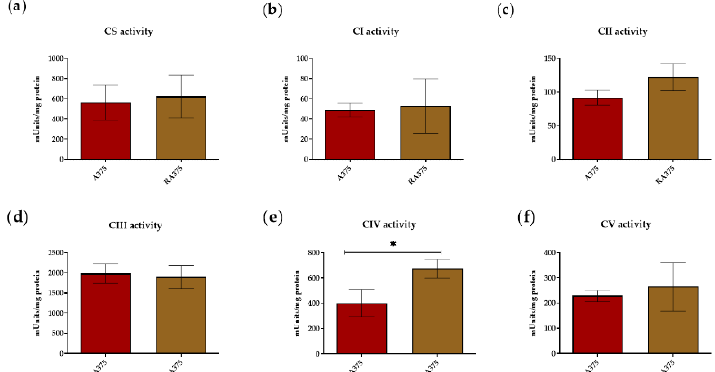
Figure 3. ( a – f ) Absolute activities of citrate synthase and OXPHOS complexes in isolated mitochondria in R-A375 and A375 cells. Citrate synthase (CS); Complex I (CI); Complex II (CII); Complex III (CIII); Complex IV (CIV); Complex V (CV). Values are given as mean ± SD. Unpaired T -test; * p ≤ 0.05. The activities of the OXPHOS complexes were normalized to the protein concentration in cell lysates. Measurements were repeated independently three times and each measurement included two replicates (n = 3).